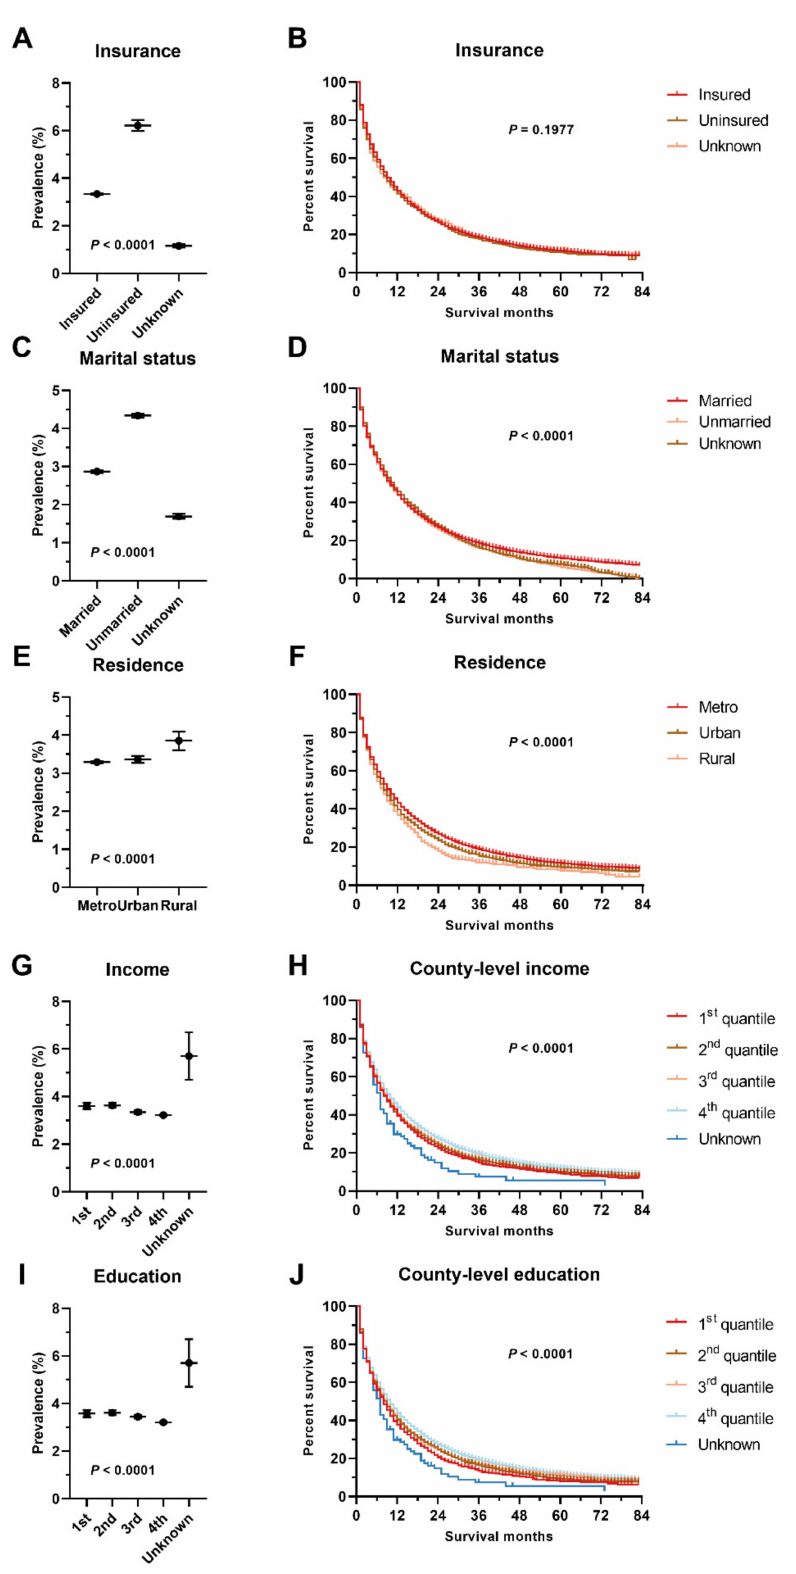
Figure 3. Disparities in prevalence and prognosis for sLM by insurance ( A , B ), marital status ( C , D ), residence type ( E , F ), county-level income ( G , H ), and county-level education ( I , J ). Statistical tests were performed by Chi-square analyses and log-rank